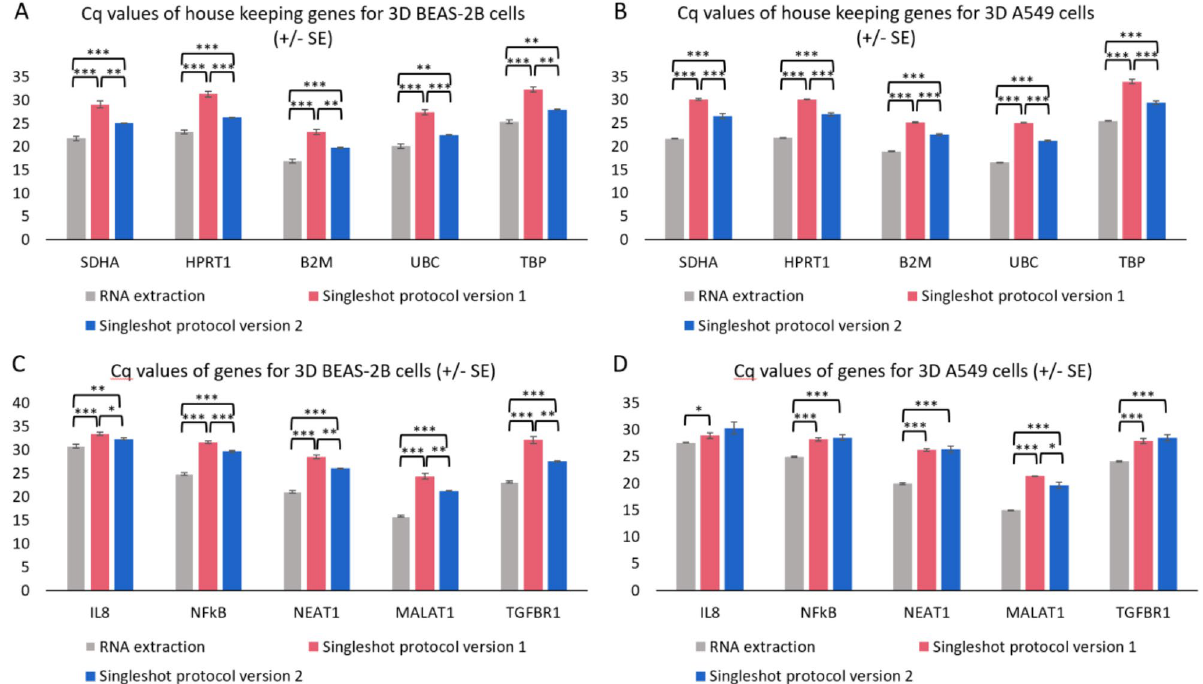
Figure 1. Cq values for five housekeeping genes (TBP, UBC, SDHA, HPRT1, and B2M), measured in two cell lines (BEAS-2B ( A ) and A549 ( B )) on RNA extracted from 3D cell cultures (grey), lysates generated using the Singleshot protocol version 1 (red) or lysates generated using the Singleshot protocol version 2 (blue). Cq values for five additional genes (IL8, NFkB, NEAT1, MALAT1 and TGFBR1), measured in two cell lines (BEAS-2B ( C ) and A549 ( D )) on RNA extracted from 3D cell cultures (grey), lysates generated using the Singleshot protocol version 1 (red) or lysates generated using the Singleshot protocol version 2 (blue). Data are presented as mean ± SE with * P < 0.05; ** P < 0.01 and *** P < 0.001 (n = 3).